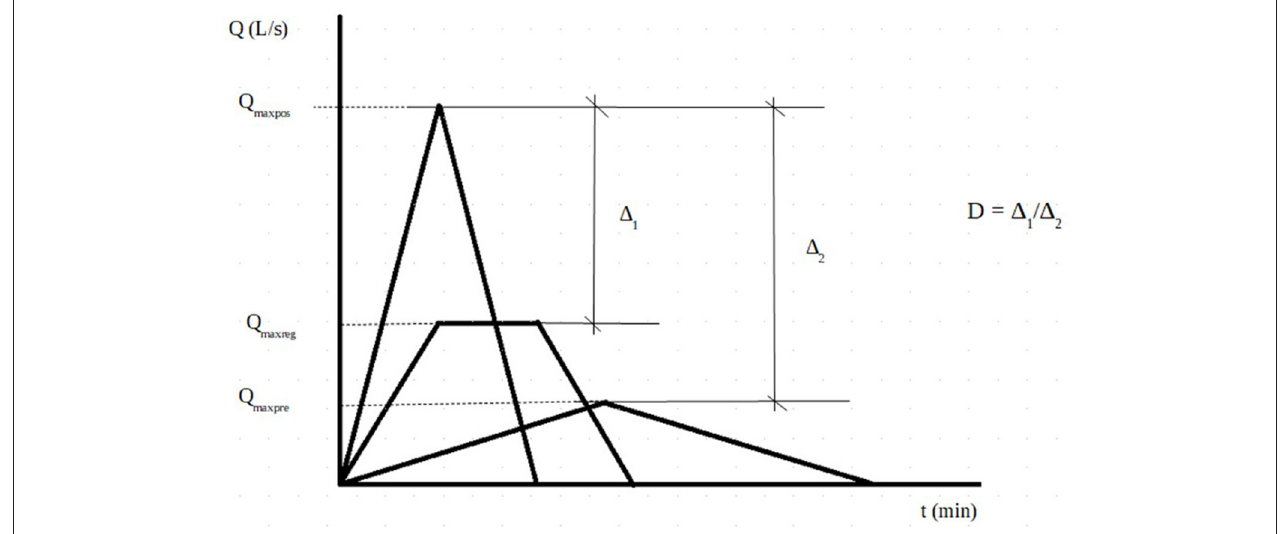
FIGURE 1 | Diagram of indicator D. Source: produced by the authors. Q maxpre , maximum lot output flow in the pre-developed condition; Q maxpos , maximum lot output flow in the post-developed condition; Q maxreg , maximum lot outlet flow with regulation through the chosen detention reservoir; The lines of the hydrographs are presented as straight for the sake of